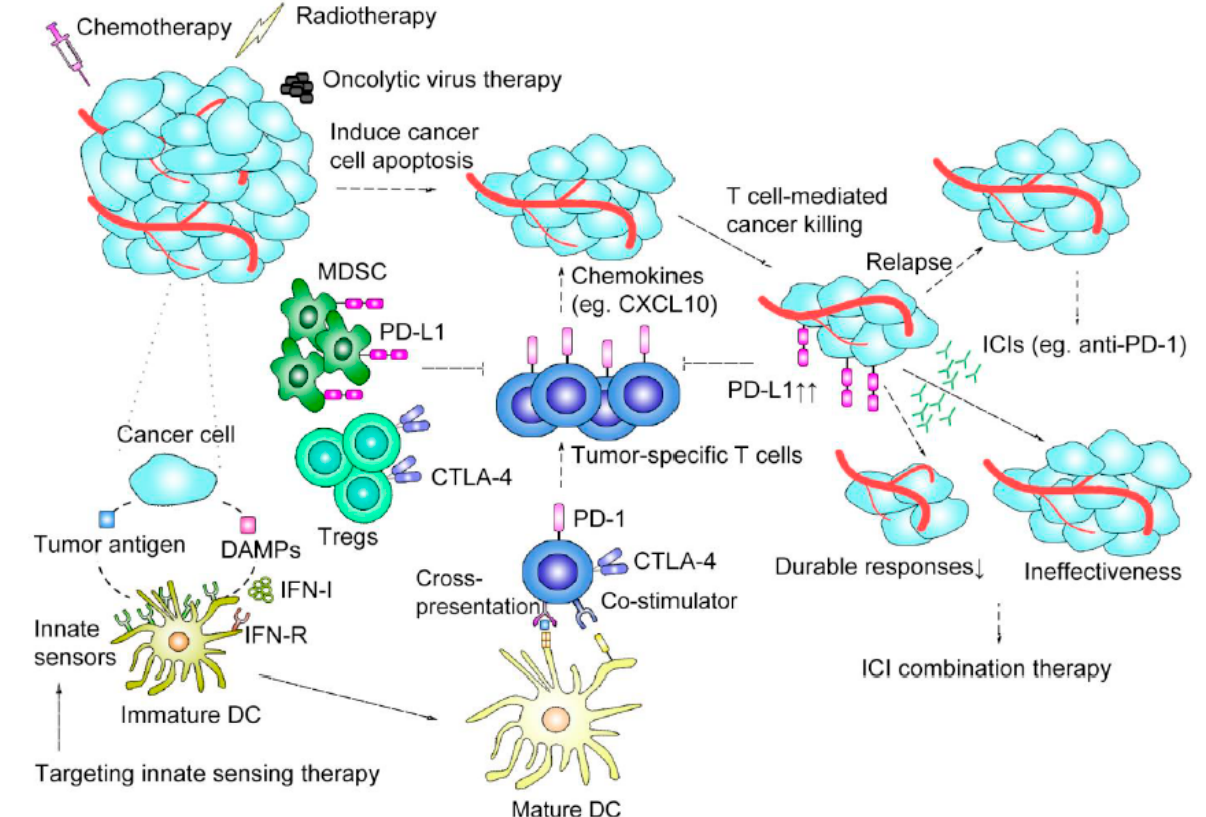
Figure 1. Immune-based mechanisms of immune checkpoint inhibitor (ICI) therapy and combination strategy rationales. Conventional cancer therapies, including chemotherapy, radiotherapy, and targeted therapy, induce cancer cell apoptosis as well as release tumor-associated antigens and various damage-associated molecular patterns (DAMPs) to activate dendritic cells (DCs) by triggering innate immune sensing pathways and type I interferons (IFN-I) ligating IFN receptors (IFN-Rs) on DCs. The interactions between cancer cells and activated DCs promote the cross-priming and recruitment (though chemoattractants such as CXCL10) of tumor-specific T cells for additional T cell–mediated killing of tumor cells. Conventional cancer therapies can also promote immunosuppression in the tumor microenvironment TME and cause resistance to immunotherapy by mechanisms involving the upregulation of PD-L1 on tumor cells and the accumulation of myeloid-derived suppressor cells (MDSCs) and regulatory T cells (Tregs). ICIs can restore the function of exhausted T cells or enhance that of cytotoxic CD8 + T cells to regain antitumor responses. Regarding ICI treatment failure attributable to initial ineffectiveness or the lack of durable responses, combination treatments involving the joint application of conventional therapies or immunotherapy can enhance the specific antitumor immune response, thereby achieving better tumor control. Oncolytic virus therapy, therapies targeting innate sensors, and other immunotherapies can strengthen the antitumor immune response.